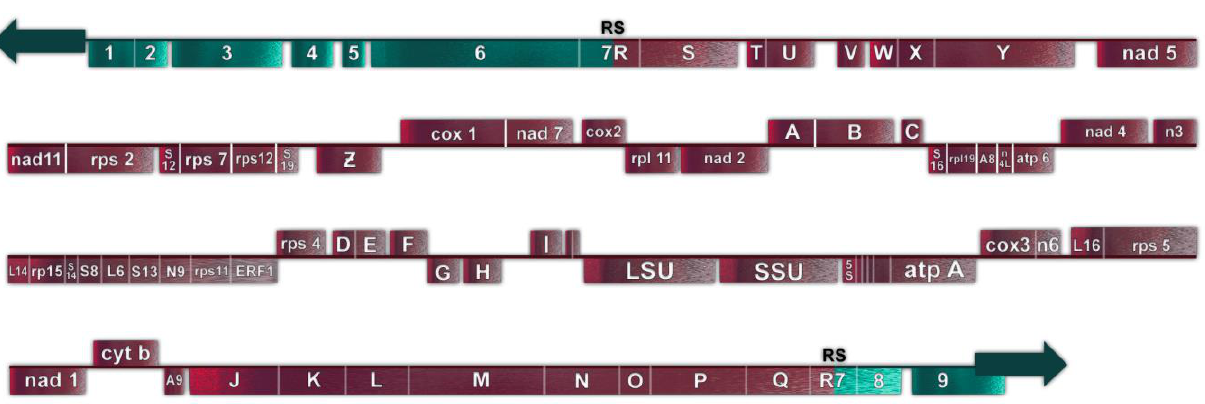
Figure 5. Representation of the 77.3 kb linear mtDNA. Gene symbols are as defined in Table 1. DNA derived from the circular mtDNA is shown in magenta; DNA derived from the linear mF plasmid is shown in teal.